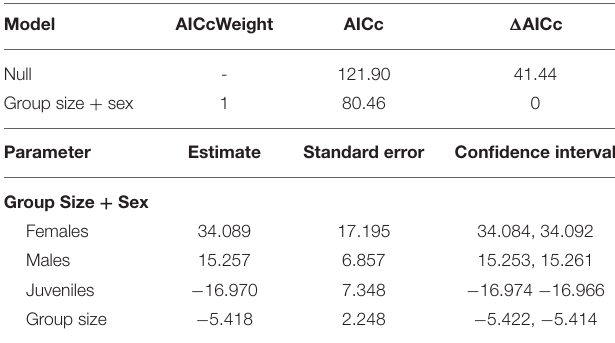
TABLE 1 | Top model set of the factors associated with whether or not an individual displays helping behavior (for a full list of models see Supplementary Material S2 ).